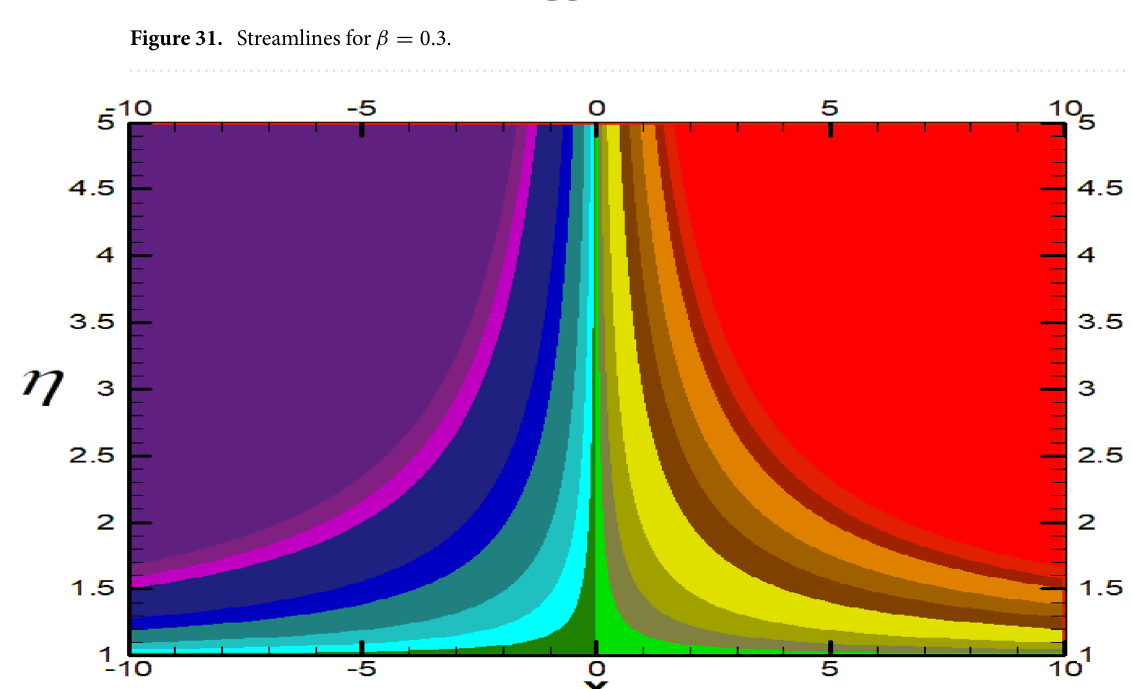
Figure 32. Streamlines for β